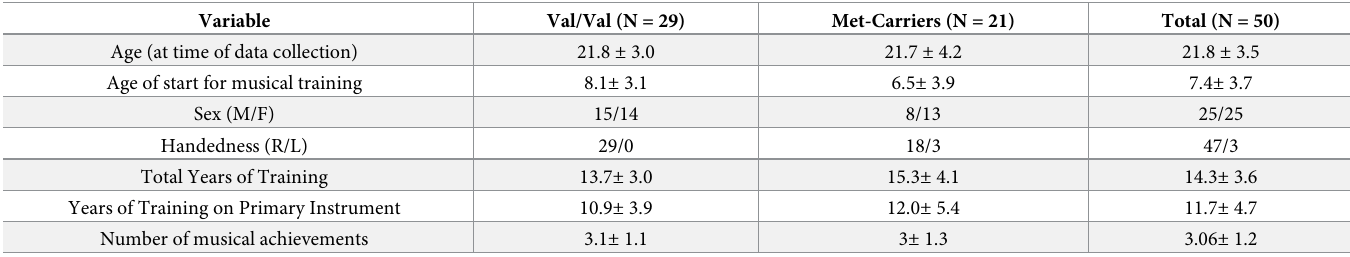
Table 1. Demographic variables for the musician sample by carrier